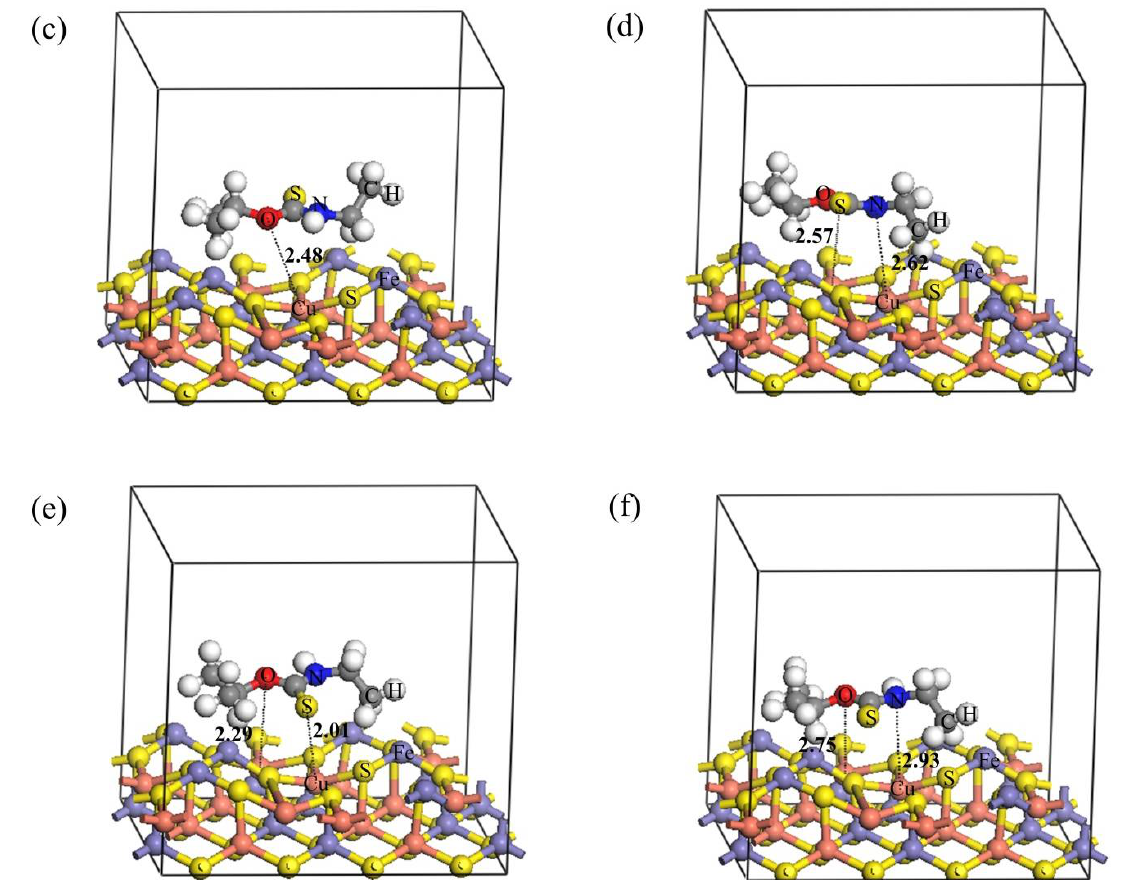
Figure 19. Optimized adsorption configurations of Z-200 on chalcopyrite (112) crystal plane (( a ) adsorption of carbonyl S; ( b ) adsorption of N; ( c ) adsorption of O; ( d ) simultaneous adsorption of